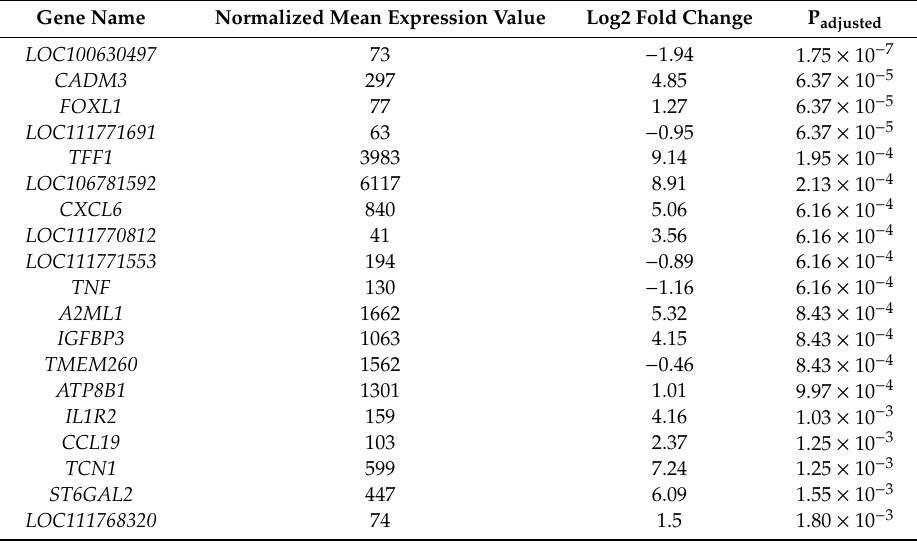
Table 10. Top 20 significantly di ff erentially expressed genes between asthmatic horses in an exacerbated state and asthmatic horses in remission according to the adjusted p -value. The normalized mean expression values calculated by DESeq2, the log2 fold change, as well as the adjusted p -values are